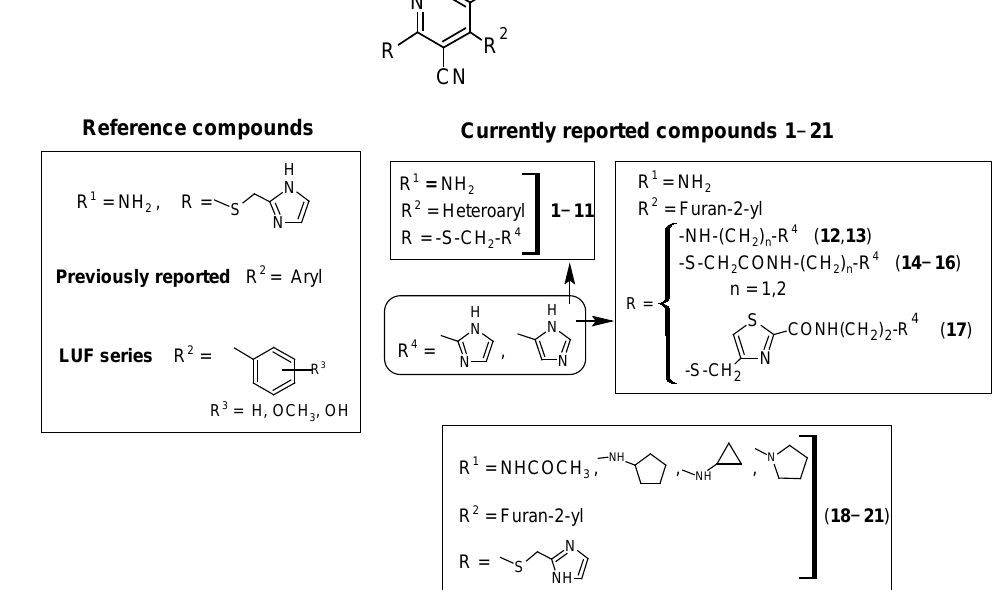
Figure 1. Lead structures and currently reported amino-3,5-dicyanopyridine-based adenosine receptor ligands.